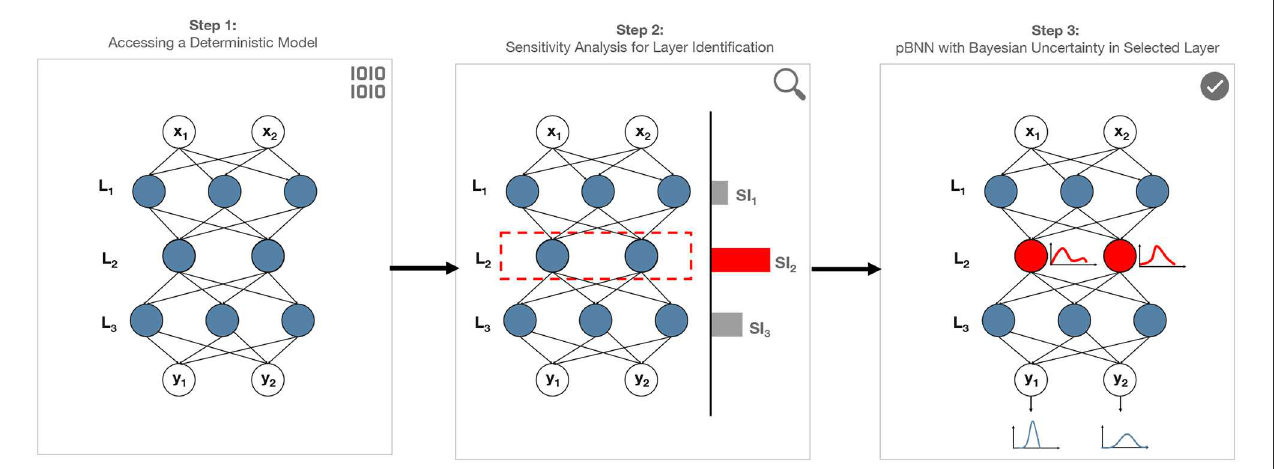
FIGURE1 Proposed framework to address scalability challenges of Bayesian inference on neural networks by building pBNN: Step (1) represents a million-parameter deterministic NN. Step (2) conduct sensitivity analysis to identify the layer that has greatest impact on model output. Step (3) conduct Bayesian inference on the most sensitive layer to build pBNN. The resulting pBNN combines the strengths of both deterministic and Bayesian NNs, allowing